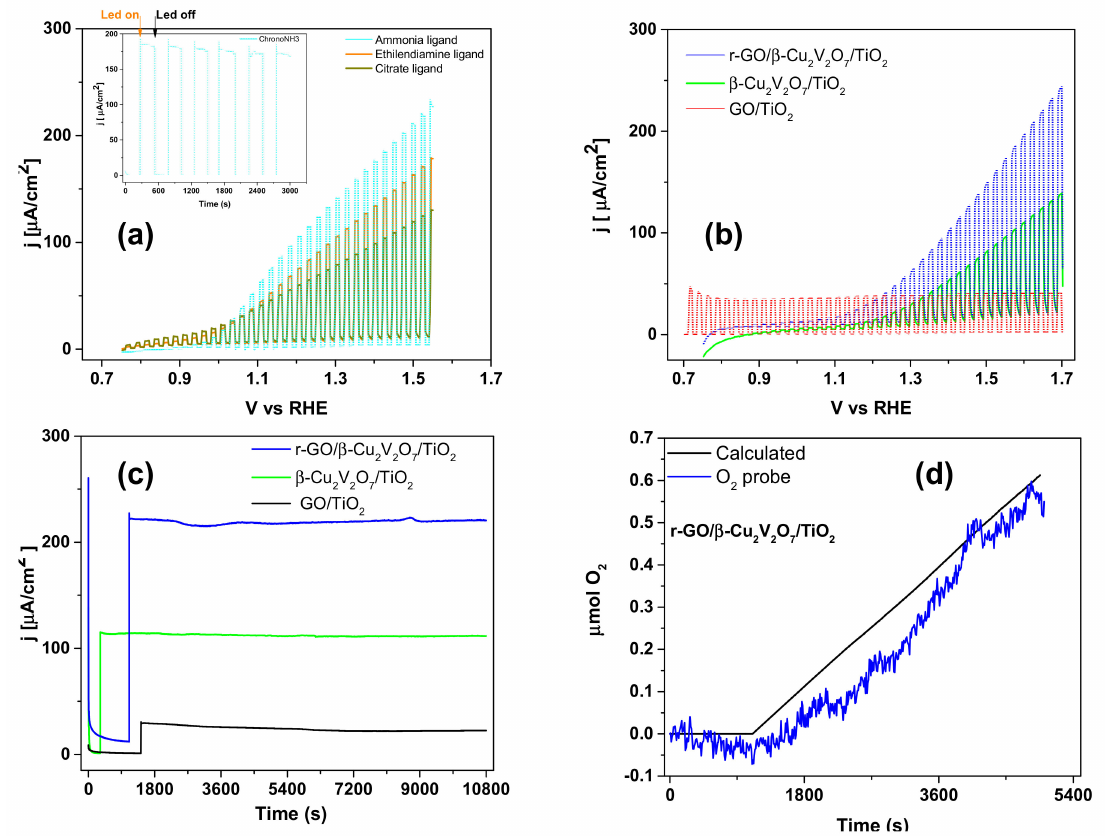
Figure 5. Photoelectrochemical performances: chopped Linear Sweep Voltammetry (LSV) (Borate Buffer pH = 9.2, scan rate 5 mV/s) of β -Cu 2 V 2 O 7 deposited from aerosol solutions containing NH 3 , EN or CA, as ligands, on FTO ( a ) (the inset shows a chronoamperometry at 1.5 V vs. Reversible Hydrogen Electrode (RHE) of a sample deposited with ammonia as ligand); chopped LSV (Borate Buffer pH = 9.2, scan rate 5 mV/s) of samples deposited on TiO2 NRs ( b ); chronoamperometry of β -Cu 2 V 2 O 7 /TiO 2 , r-GO/ β -Cu 2 V 2 O 7 /TiO 2 and r-GO/TiO 2 at 1.5 V vs. RHE ( c ); comparison of calculated and